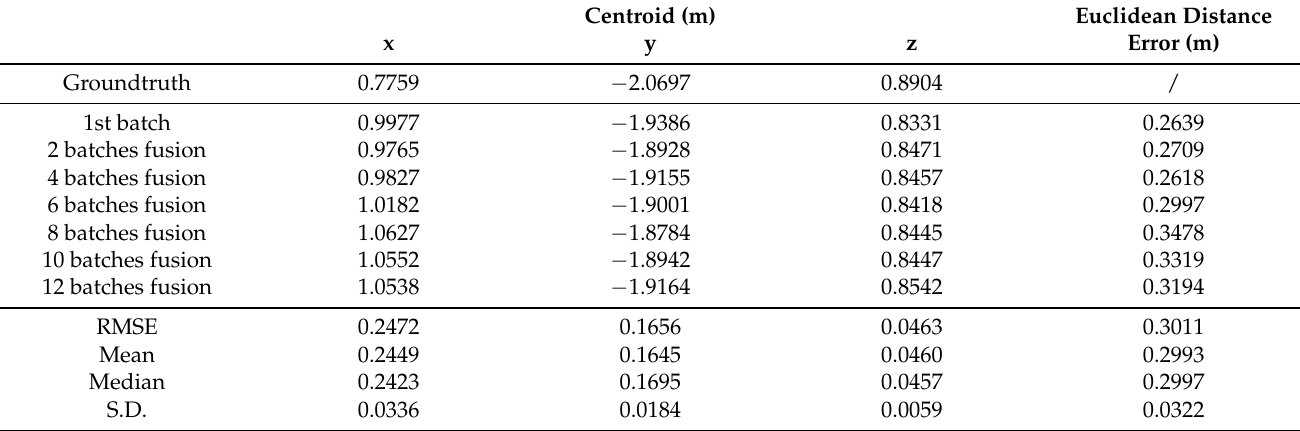
Table 4. Object positioning based on multi-frame